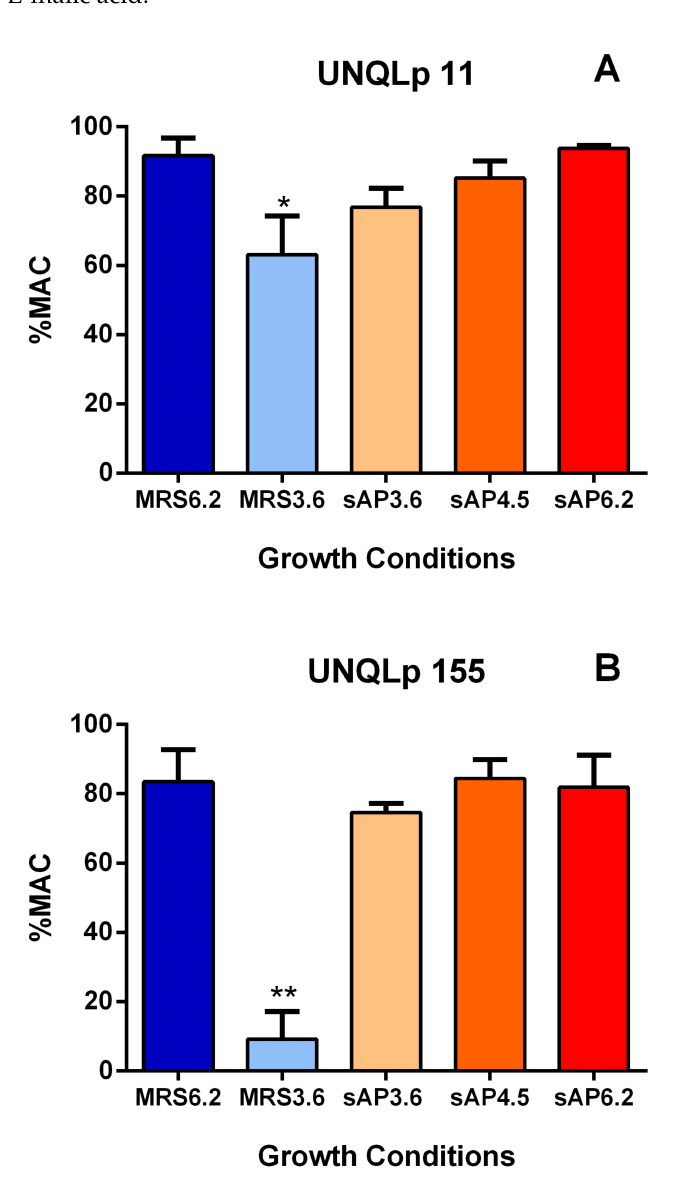
Figure 3. Percentage of L-malic acid consumption (% MAC ) of UNQLp 11 ( A ) and UNQLp 155 ( B ) strains, after incubation during 7 days in synthetic wine (ethanol 13% v / v , pH 3.5), at 21 ◦ C. The statistical analysis was completedusing ANOVA and Dunnett’s multiple comparisons test with thecontrol (MRS pH 6.2). Differences were considered significant when p < 0.05 (*) or p < 0.01